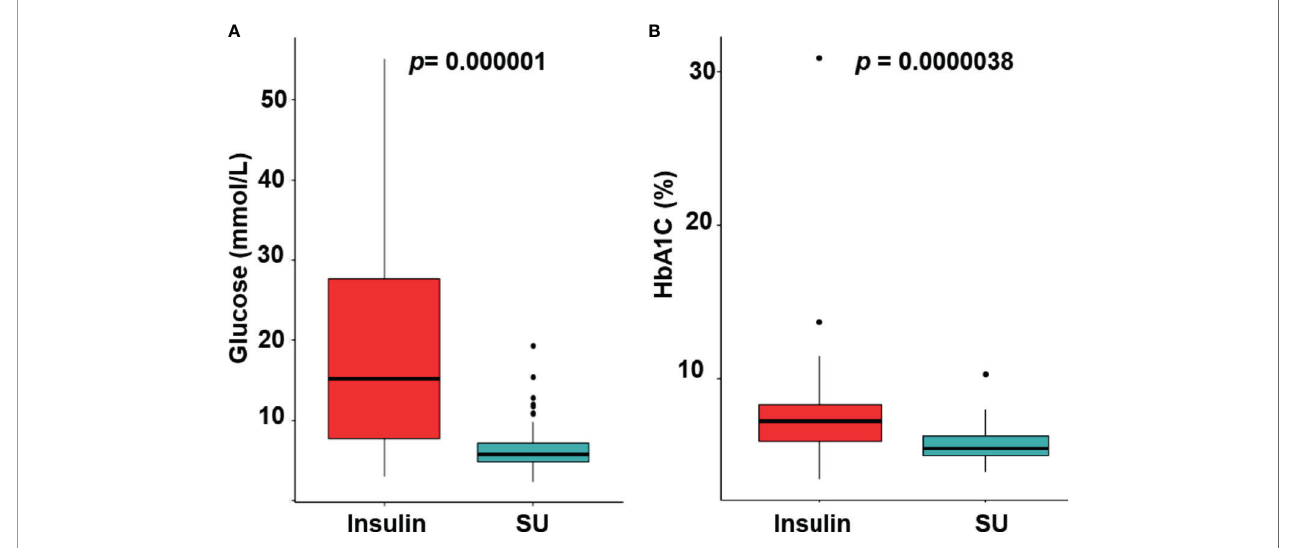
FIGURE 2 | The glycemic control (A) and reduction of HbA1C levels (B) with switching from insulin to sulfonylurea therapy. SU,